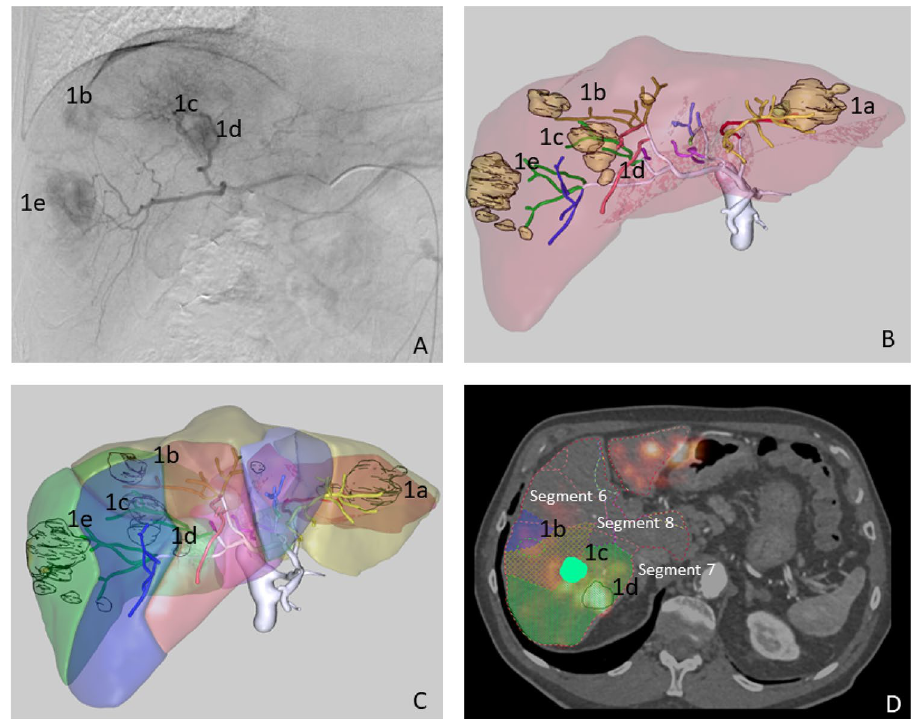
Figure 2. Patient 1. Multinodular HCC in the arteriography study ( A ). MeVis study showing arterial and liver segment territories ( B , C ) as well as tumor nodules (1a to 1e). MeVis liver segment contours imported on co-registered 90 Y PET-pCT images ( D ) showing that tumor 1b was mainly irrigated by segment 8 artery (and slightly by segment 6 artery); 1c by segment 7 and 8 segment arteries; and 1d exclusively by segment 7 artery.